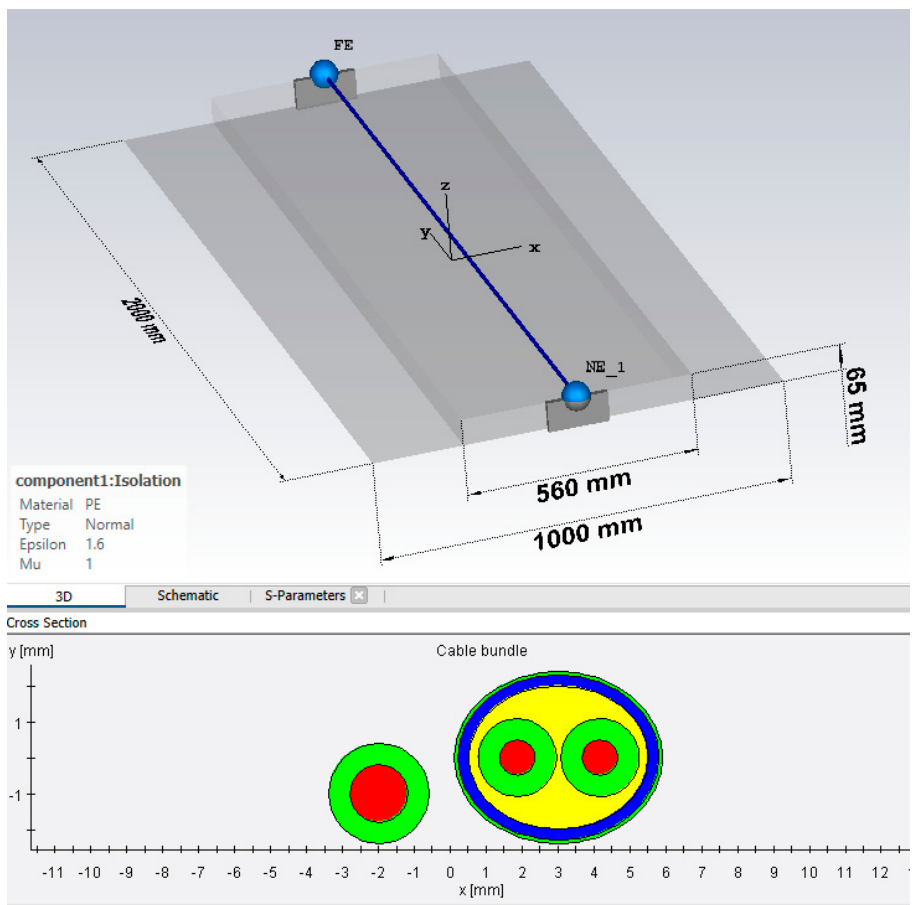
Figure 9. The view of 3D model and cross section of the cable bundle.